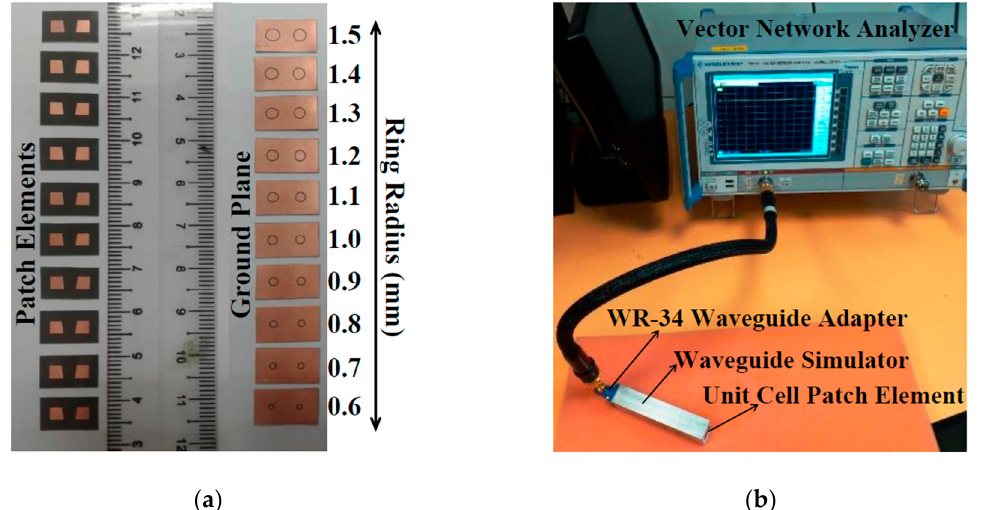
Figure 5. ( a ) Fabricated unit cells of asymmetric patch element with a variable radius of ground ring slots; ( b ) Unit cell measurement setup.